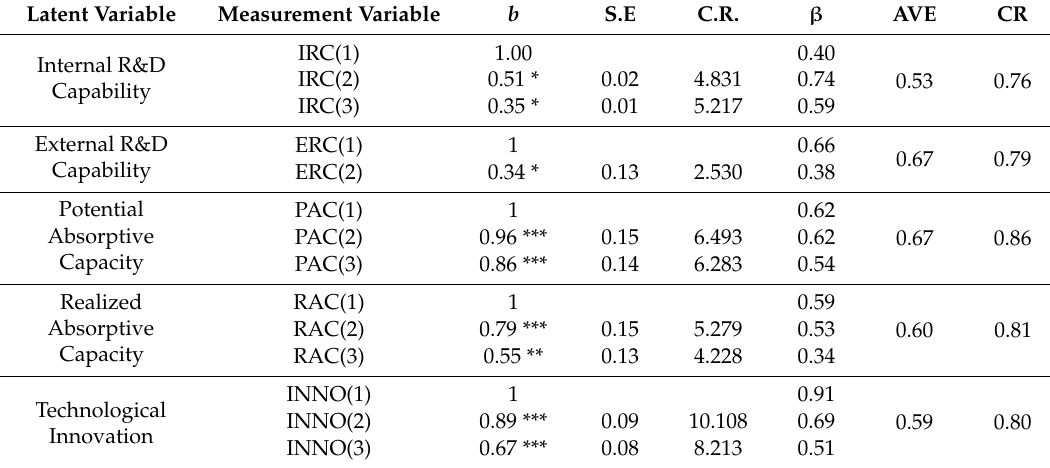
Table 6. Results of measurement model testing.